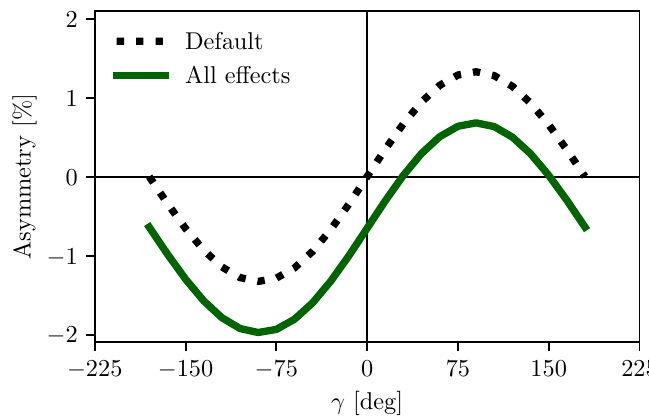
Figure 2 . The asymmetry A total as a function of γ calculated to O ( (cid:28) ) using eq. (2.22). The calculation is made using for (black dotted line) the default case where ∆ h = 0 and (green) including neutral kaon CP -violation and material interaction with r χ = (cid:28)